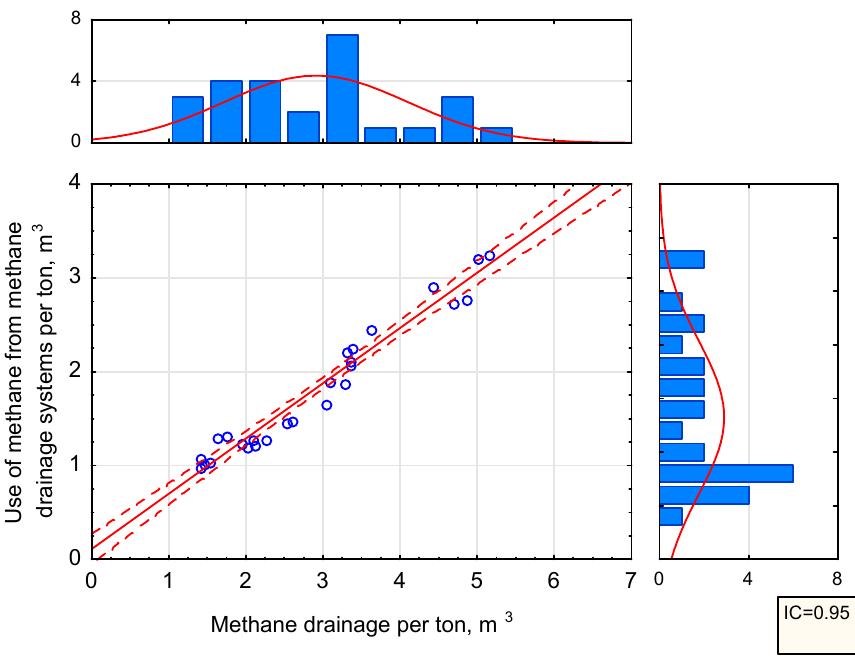
Figure 11. Relationship between methane drainage and uses of methane from methane drainage system per one ton in Poland.